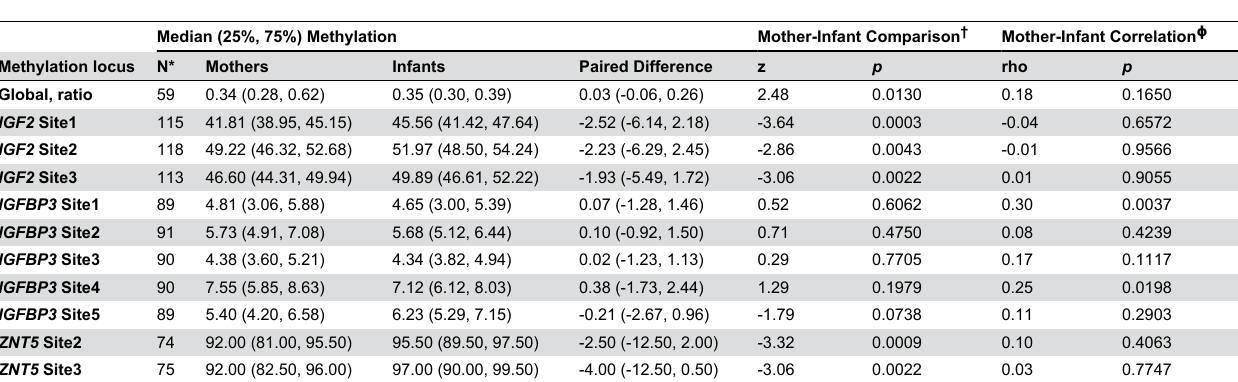
Table 3. Comparison of methylation levels in maternal-infant pairs.